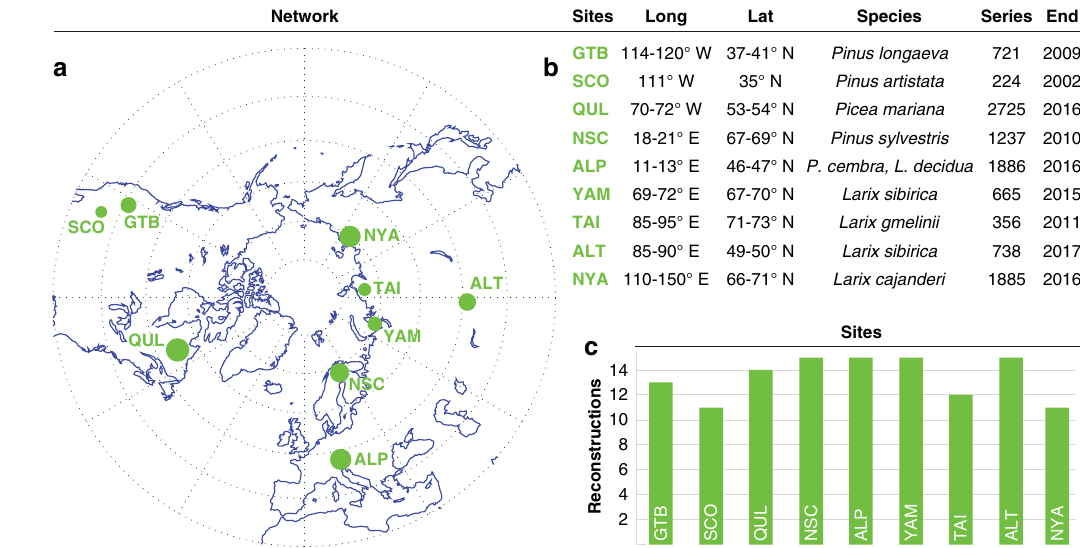
Fig. 1 Dendro network . a Spatial distribution of the 15 tree-ring width (TRW) sites with three of them in North America (GTB, SCO and QUL), two in Europe (NSC and ALP), three in northern Siberia (YAM, TAI and NYA), and one in inner Eurasia (ALT). Dot size represents TRW sample replication, ranging from 224 series in SCO to 2725 series in QUL. b Longitude and latitude, species, the total number of series, and last ring of the nine regional TRW datasets. c Consideration of the nine TRW datasets in the 15 ensemble reconstructions, ranging from 11 times (SCO and NYA) to 15 times (NSC, ALP, YAM,